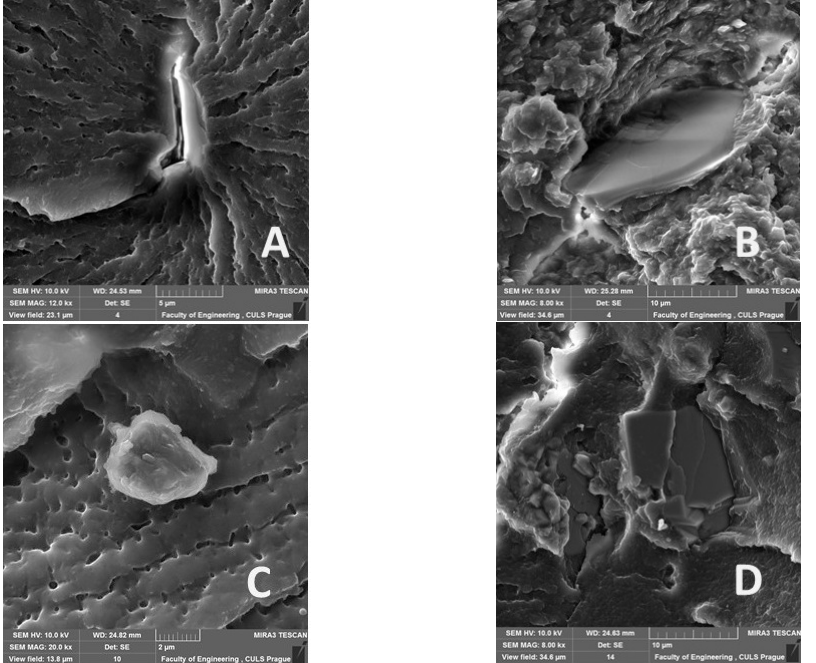
Figure 11. SEM images of fracture surface: ( A ) epoxy resin—mixing speed—460 rpm (MAX 12.00 k×, ( B ) composite material with filler NanoBent ZR2 montmorillonite—mixing speed—1700 rpm (MAG 8.00 k×), ( C ) composite material with filler CWZ-22 active carbon—mixing speed—460 rpm (MAG 20.00k×), ( D ) composite material with filler CaCO 3 calcium carbonate—mixing speed—460 rpm (MAG 8.00 k×).